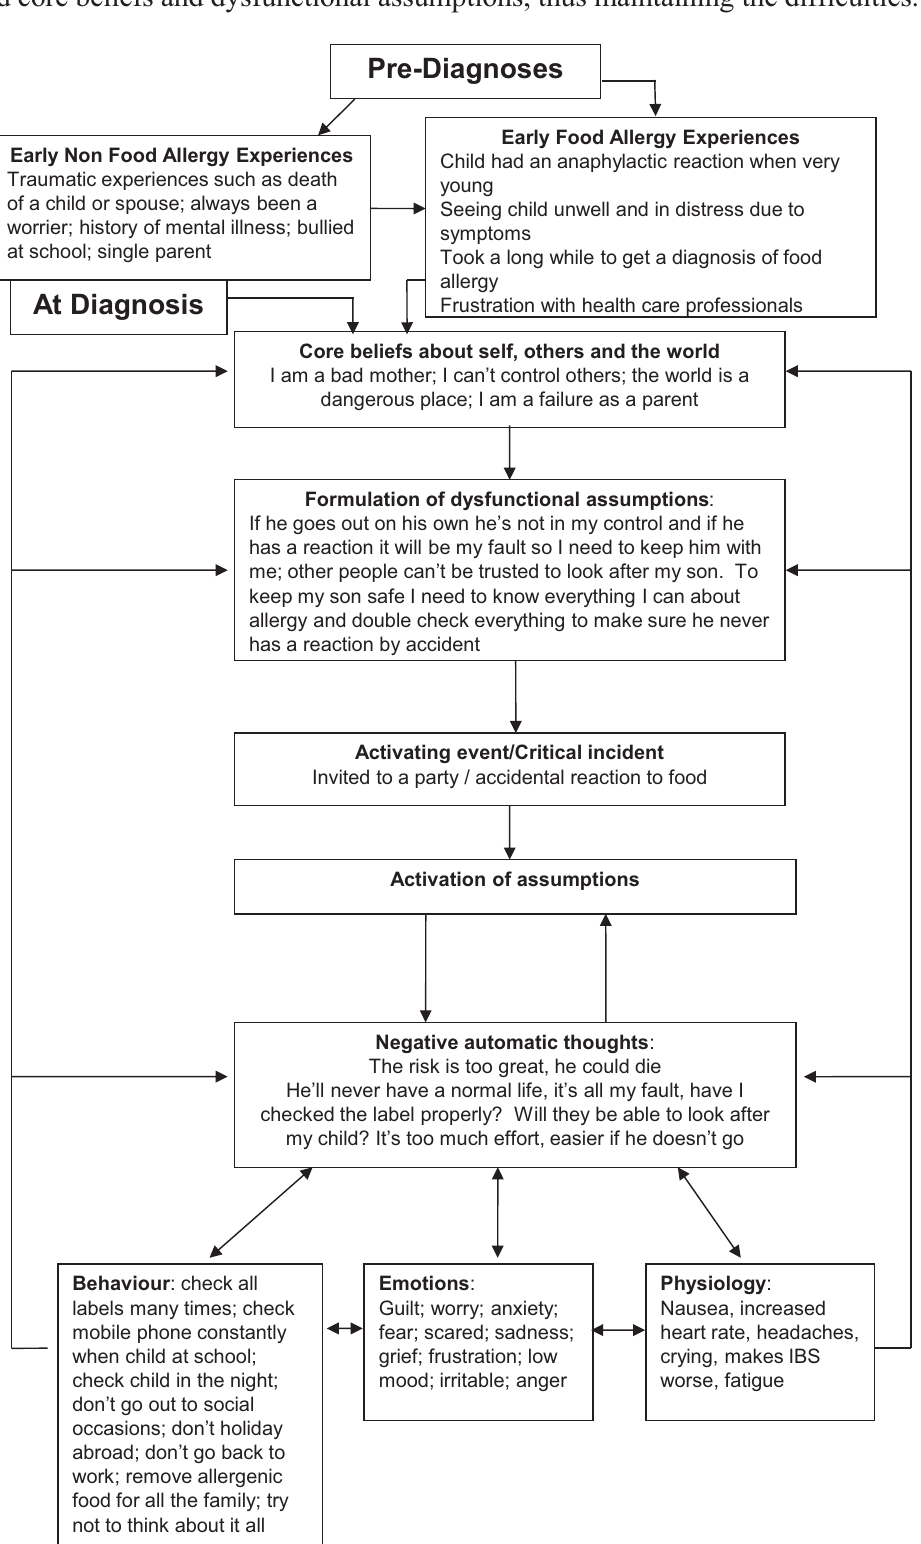
Figure 1. CBT model for food